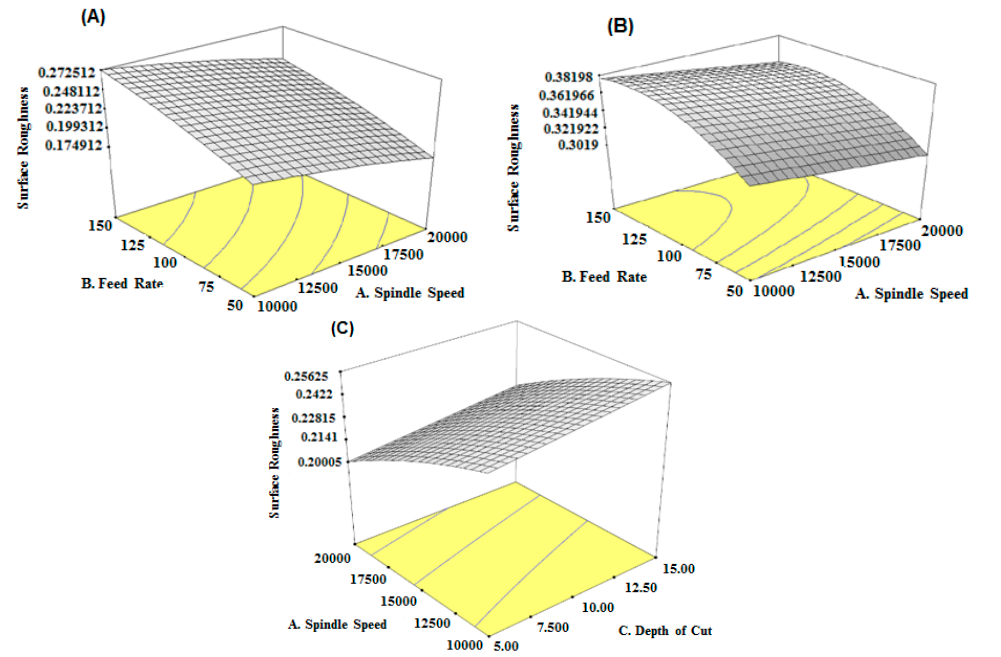
Figure 4. Three-dimensional plot of surface roughness vs. feed rate and spindle speed ( A ) For tool diameter; T1 ( B ) For tool diameter, T2; ( C ) Surface roughness vs. spindle speed and depth of cut for T1.